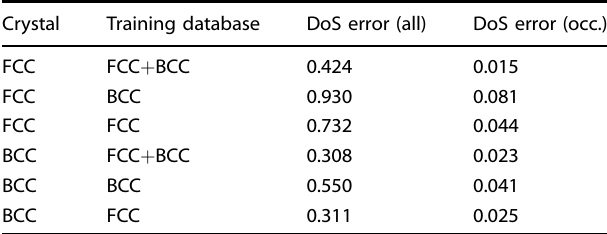
Table 2. Errors in the FCC and BCC DoS predicted with ACE models for full and restricted training databases. Crystal DoS error (occ.)